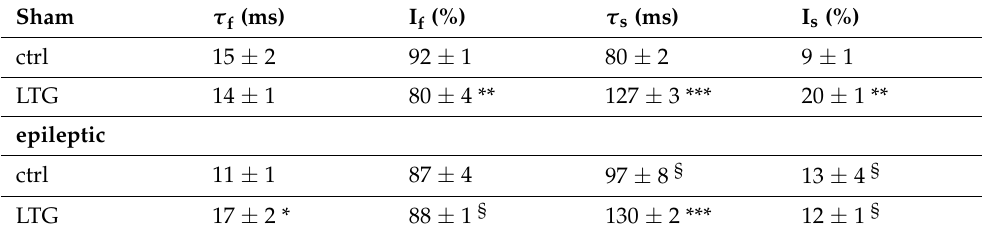
Figure 4. LTG slows I Na recovery from inactivation. ( A ) Representative I Na recording during recovery from inactivation. I Na was elicited by two step pulses, S1 (100 ms) and S2 (20 ms) to −35 mV, separated by increasing intervals at the resting membrane potential, in increments of 5 ms. Holding membrane potential was −100 mV. ( B ) Recovery from inactivation curves for sham (filled symbol) and epileptic rats (open symbol) in control (circles), and 10 µmol/L of LTG (squares). Data (±SEM) were fitted to two exponential functions (solid: control, short-dot line: LTG) to estimate the time constants. Number of animals: 3/group (ctrl and LTG). Number of cells: Sham (ctrl, LTG):19, 9; Epileptic (ctrl, LTG): 9, 15. Table 3. Time constant values of I Na recovery from inactivation. The relative weights for fast and slow components are indicated by I f and I s , respectively. Tukey test using one-way ANOVA (ctrl vs. LTG), * indicates p ˂ 0.05, ** indicates p ˂ 0.01, and *** indicates p ˂ 0.001. § indicates p ˂ 0.05 (sham vs. epileptic).